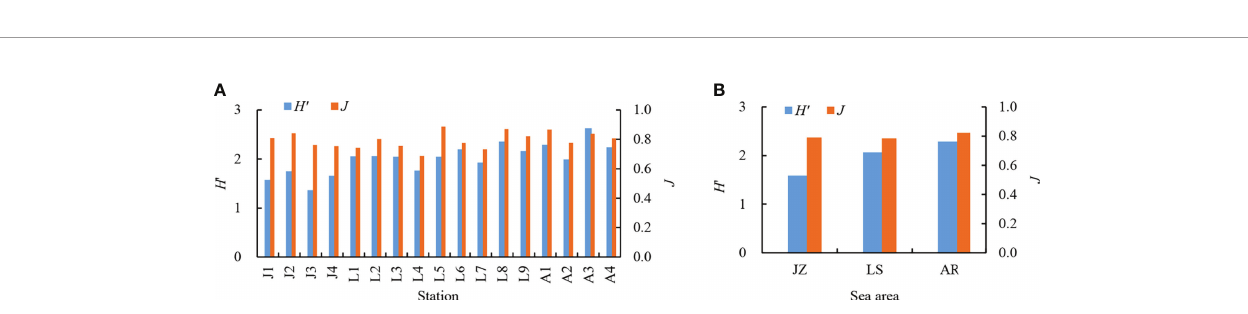
FIGURE 3 | Shannon – Wiener diversity index ( H ’ ) and Pielou ’ s evenness index ( J ) of dinocysts in the seventeen samples (A) and the three sea areas (B) . JZ, the inner Jiaozhou Bay; LS, the Laoshan coast; AR, the Amphioxus Reserve area.